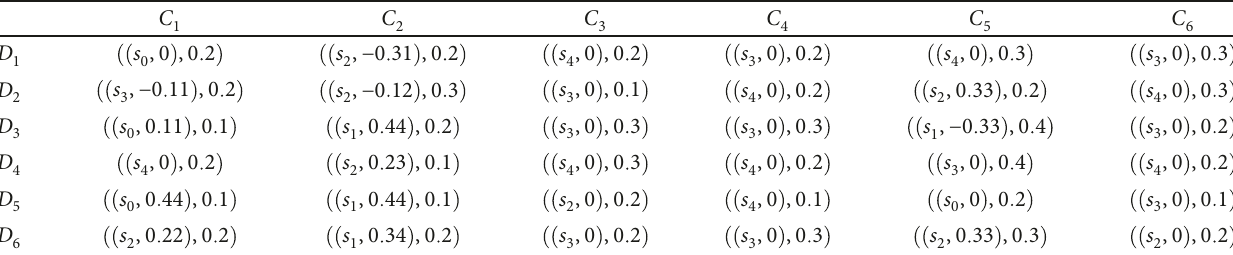
Table 2: Grey linguistic 2-tuple decision matrix Z 2 .